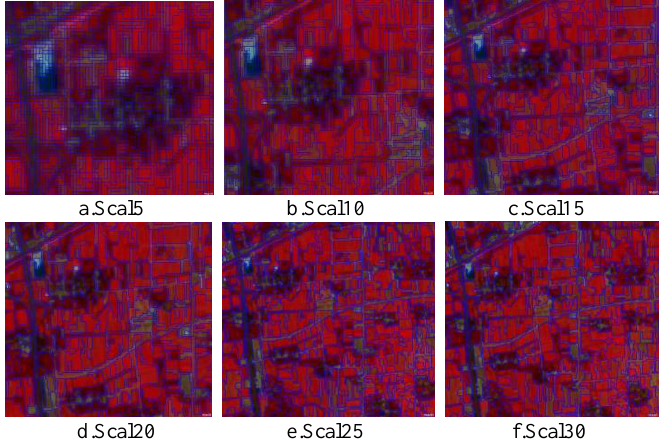
Figure 4. Segmentation results of different